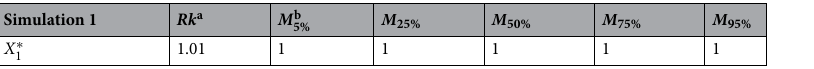
a Table 1. Results of the Simulation 1. Rk stands for the average rank of the single true predictor across 100 replications. The smaller the Rk value is, the more effective the approach performs in variable selection. stands for the minimum selection size that is required to obtain the single true predictor in each replication. The closer the different quantiles is to the total number of the true predictors, the robuster the approach is in variable